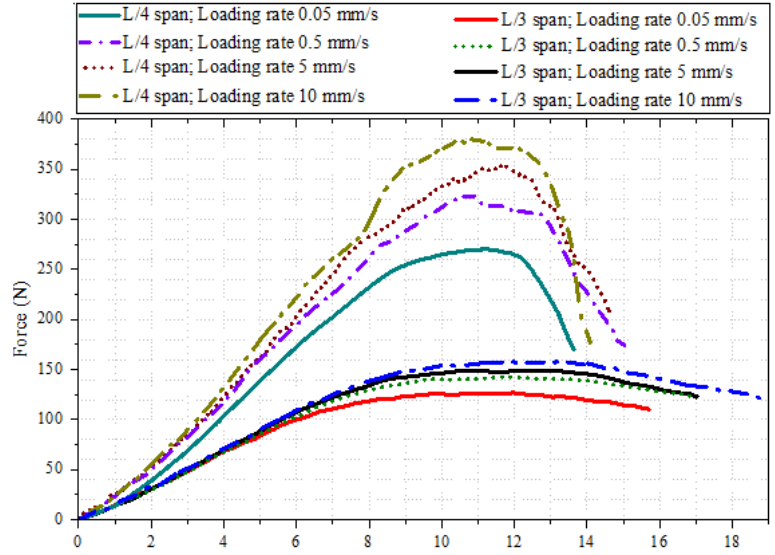
Figure 6. Comparison for the behavior of short and long-span beams under four-point flexural loading.